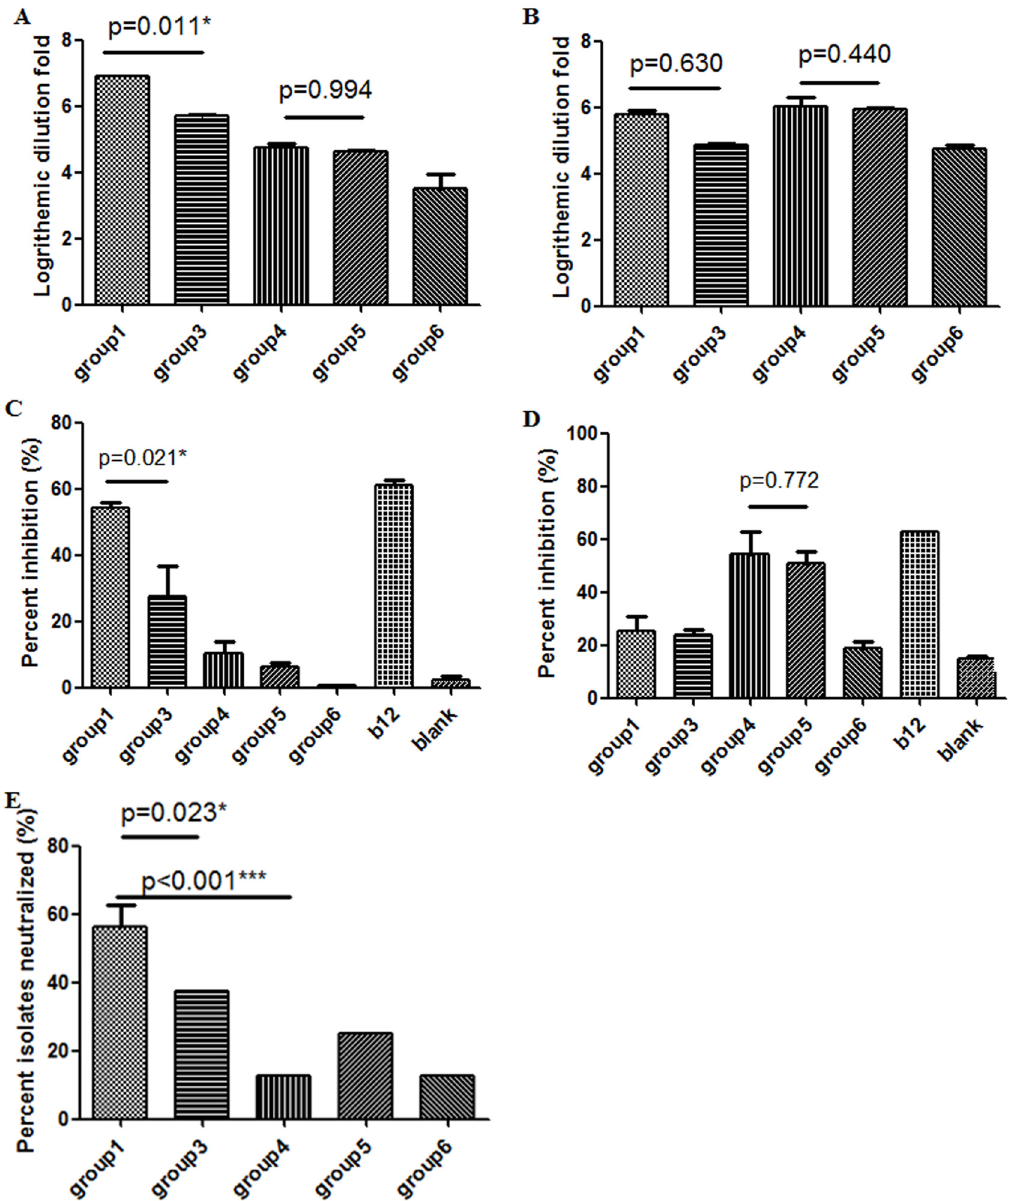
Fig 2. Characterization of bleed 6 sera and IgGs for binding and neutralization activities. A-B: Titration of bleed 6 sera for gp140 SF162 trimer (A) and RSC3 (B). C-D: Competition of rabbit IgGs with mature human IgG1 b12 for binding to gp140 SF162 (C) and RSC3 (D). Mature IgG1 b12 was included as control. For “ blank ” , no IgG was added. E: Neutralization breadth. Percent isolates neutralized by rabbit IgGs from each group (IC 50 below 150 μ g/mL) is shown. IgG1 b12 was tested at a maximum concentration of 20 μ g/ml in the TZM-bl assay. IC 50 > 20 μ g/mL was defined as non-neutralizing. One-way ANOVA was used for statistical analyses using SPSS. Pre-immunization rabbit IgGs from each rabbit were also tested and all IC 50s were > 150 μ g/mL (not shown).